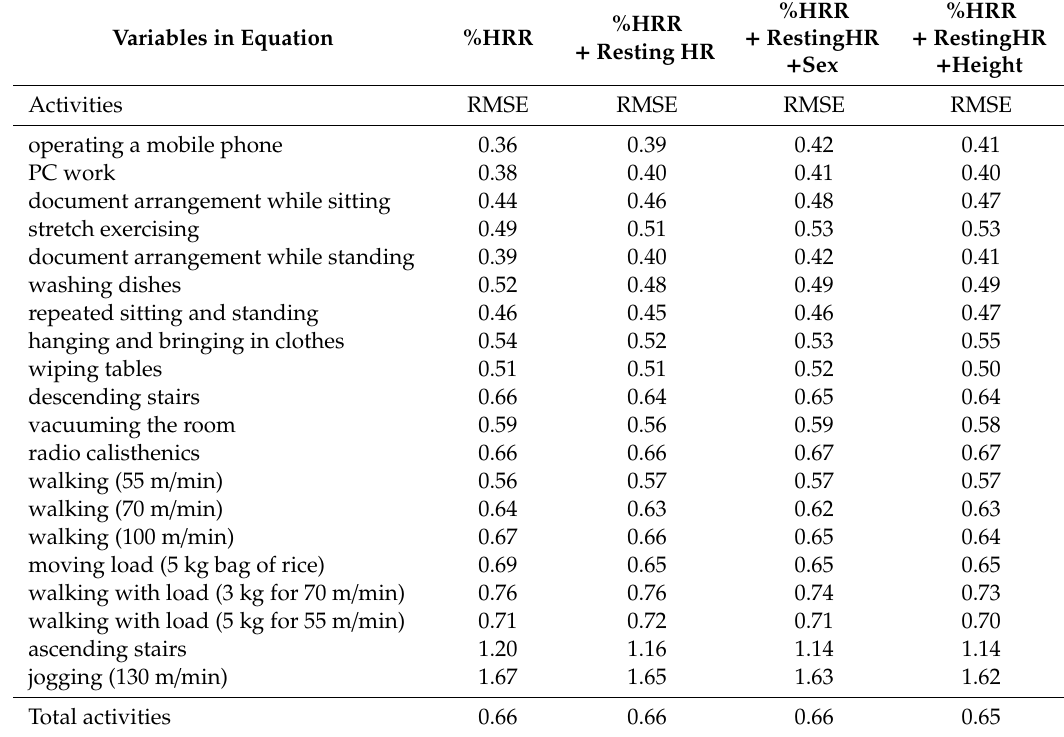
Table 7. Root mean square error (RMSE) of the predictive equations with leave-one-out